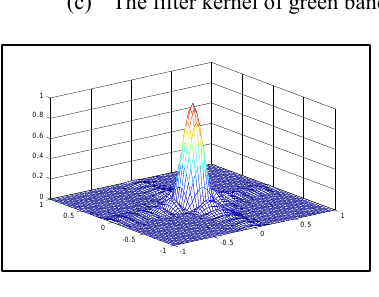
(d) The filter kernel of red band Figure 2 The filter kernels based on MTF in three